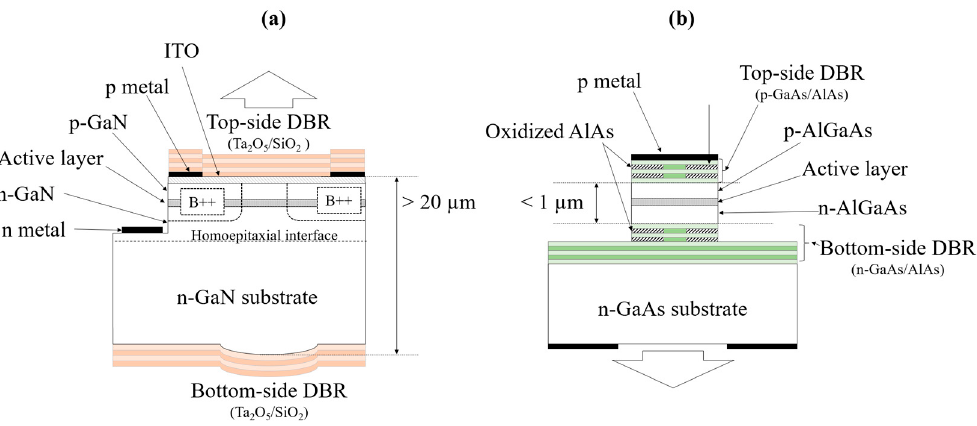
Figure 2. Schematic diagrams of ( a ) GaN-based VCSEL, the focus of this review, and ( b ) a typical GaAs-based VCSEL.